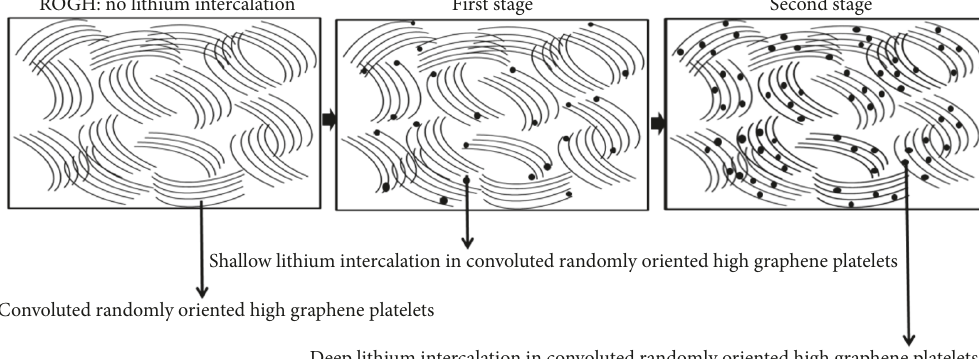
Figure 9: Predicted model for different stages of lithium intercalation in